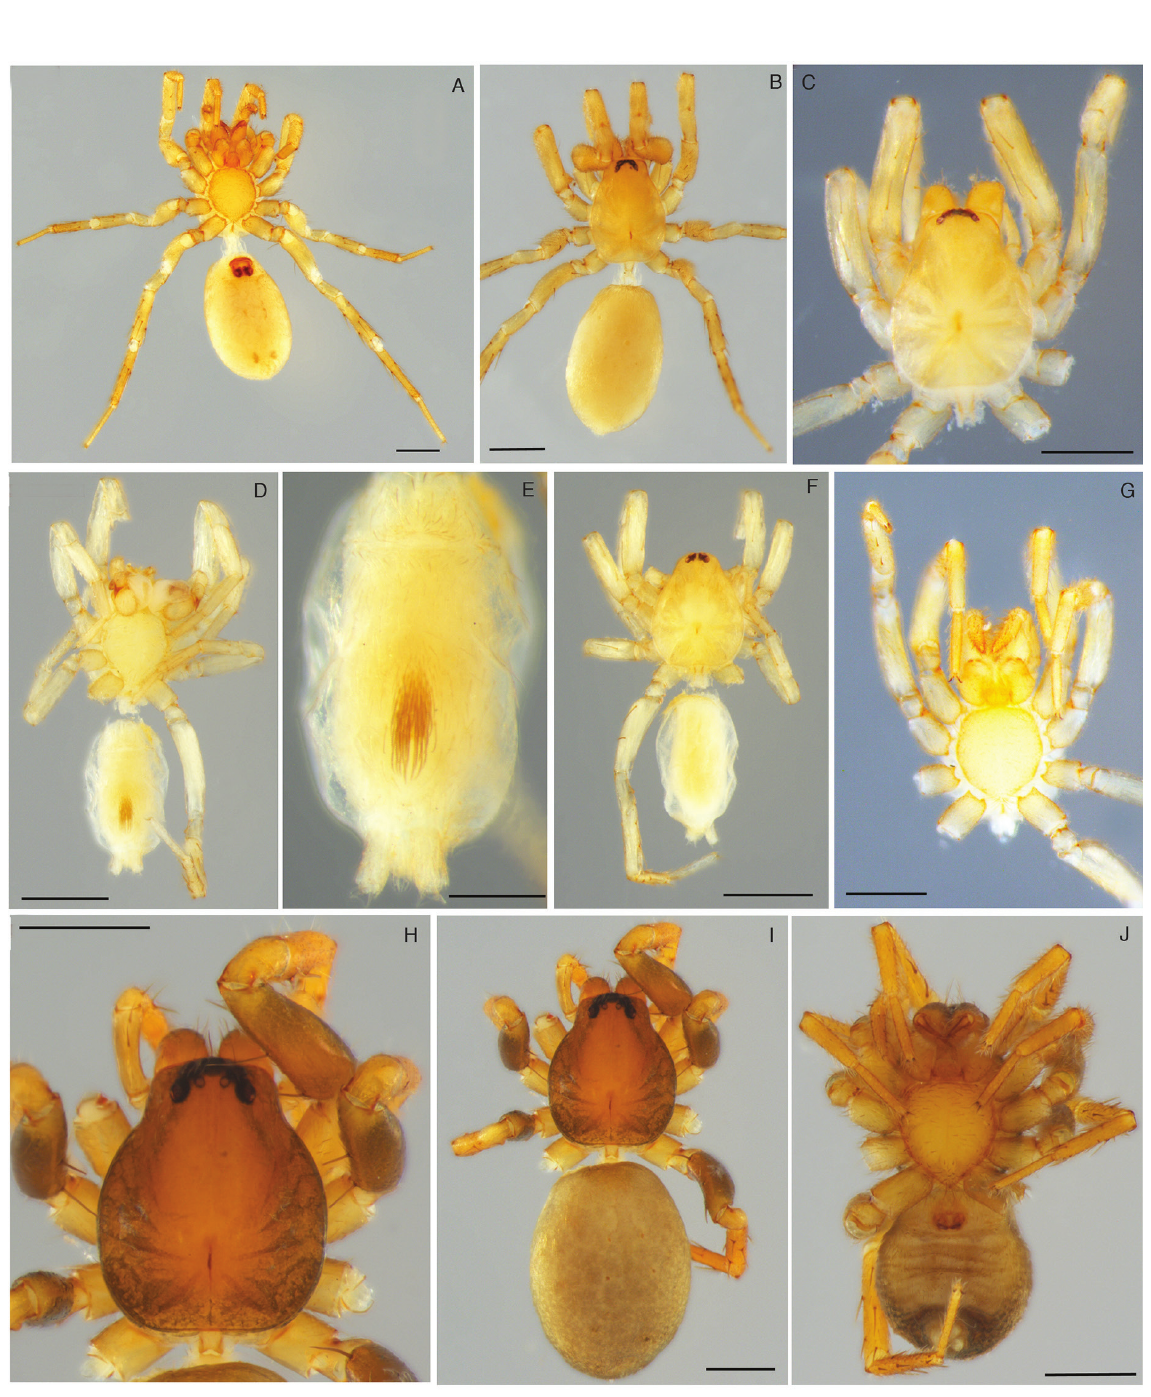
Fig. 3. A-B. Cteniogaster sangarawe sp. nov. A. ♀, habitus, ventral view. B. Idem, dorsal view. C-D. Cteniogaster taxorchis sp. nov. C. ♀, prosoma, dorsal view. D. Idem, ventral view. E-G. Cteniogaster nana sp. nov. E. ♂, habitus, ventral view. F. Idem, abdomen, ventral view. G. Idem, habitus, dorsal view. H-J. Cteniogaster lampropus sp. nov. H. ♀, prosoma, dorsal view. I. Idem, habitus, dorsal view. J. Idem, ventral view. Scale bars: A-D, F-J = 0.5 mm; E = 0.2